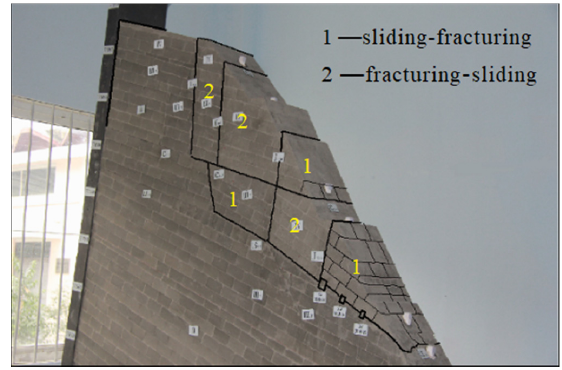
Figure 13. Failure modes of the slope.